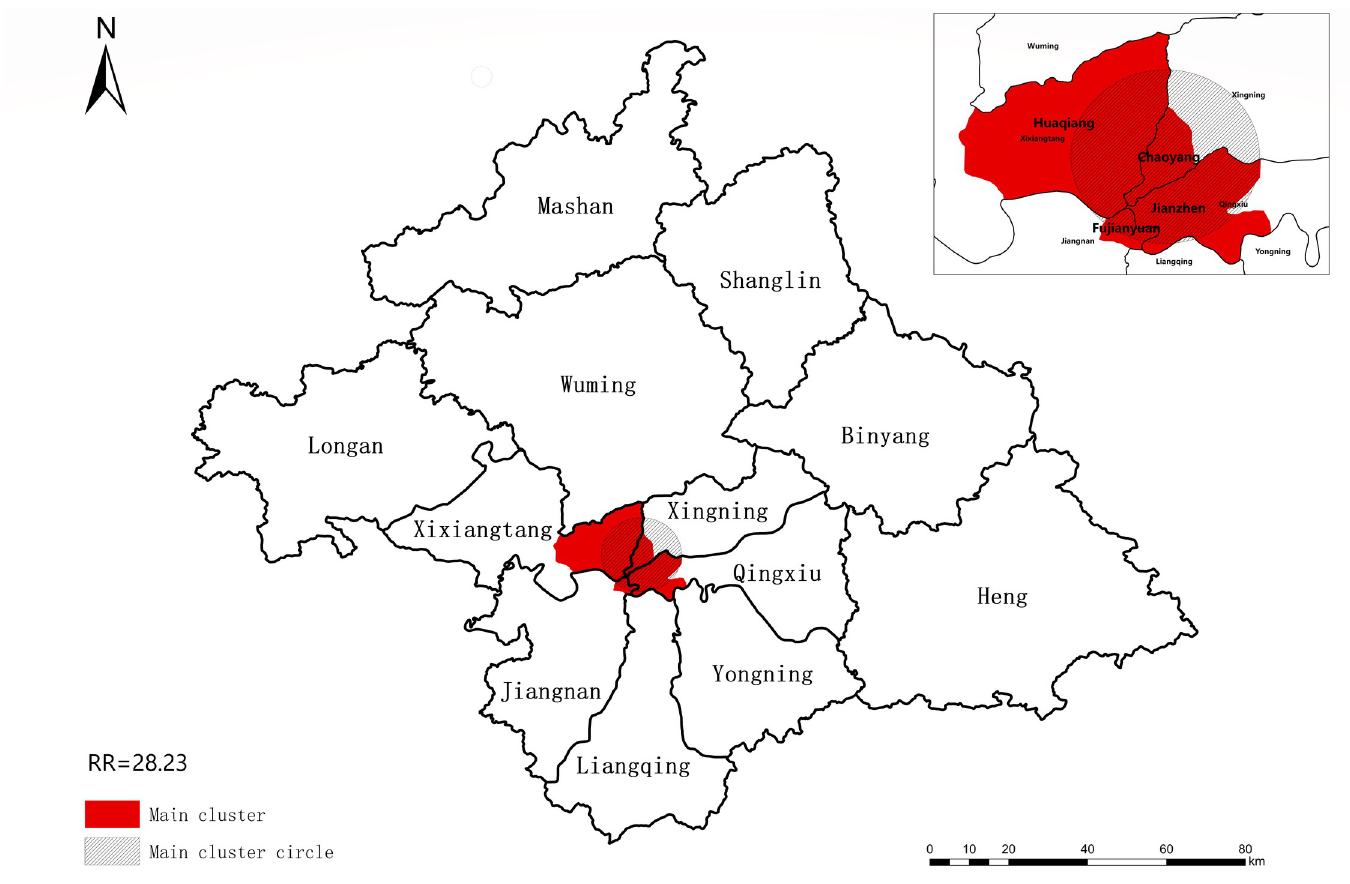
Fig 5. SaTScan for overall reported incidence of pulmonary tuberculosis among students in Nanning from 2012 to